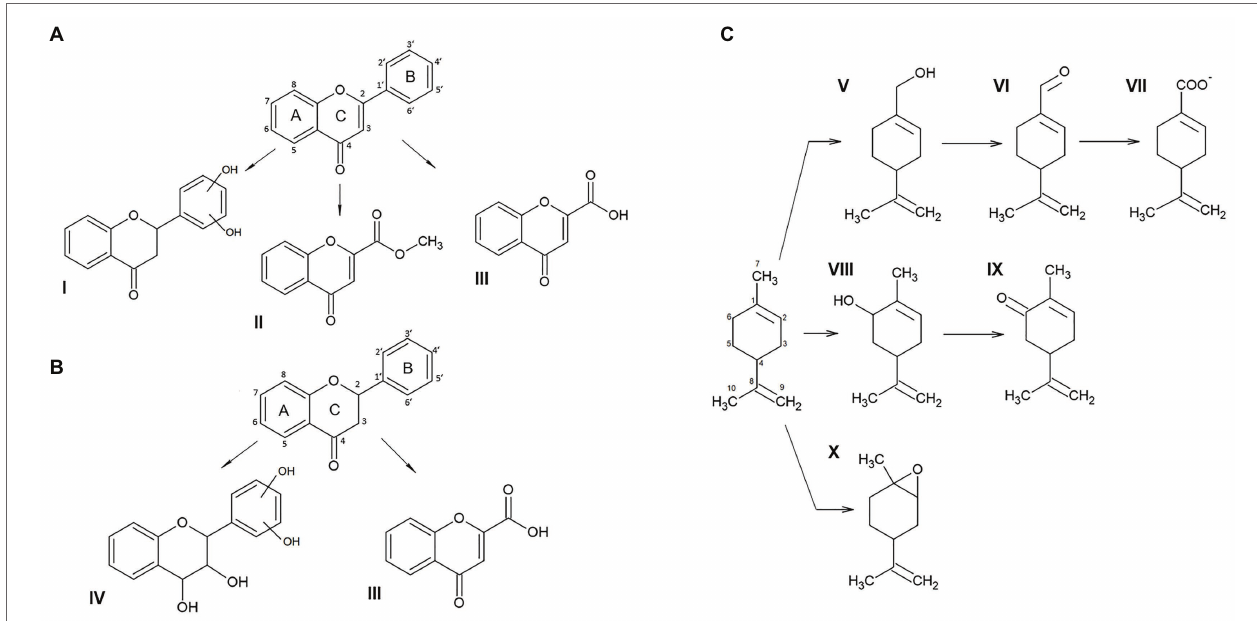
FIGURE 4 | Products of flavone (A) , flavanone (B) , and (S)-limonene (C) degradation mediated by the JAB1-borne biphenyl 2,3-dioxygenase (BPDO). Compounds: I, 2-(m,n-dihydroxyphenyl)chromane-4-one; II, methyl 4-oxo-4H-chromene-2-carboxylate; III, 4-oxo-4H-chromene-2-carboxylic acid; IV, 2-(m,n-dihydroxyphenyl) chromane-3,4-diol; V, perillyl alcohol; VI, perillyl aldehyde; VII, perillic acid; VIII, carveol; IX, carvone; and X, limonene